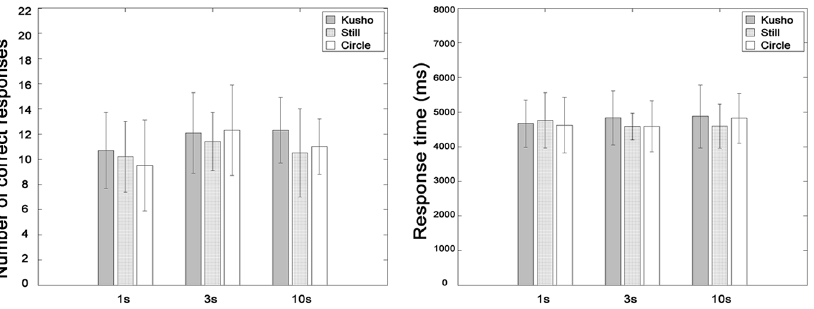
Fig 5. Correct response and response time in the simultaneous presentation task. The error bar indicates standard deviation. There were no significant effects at